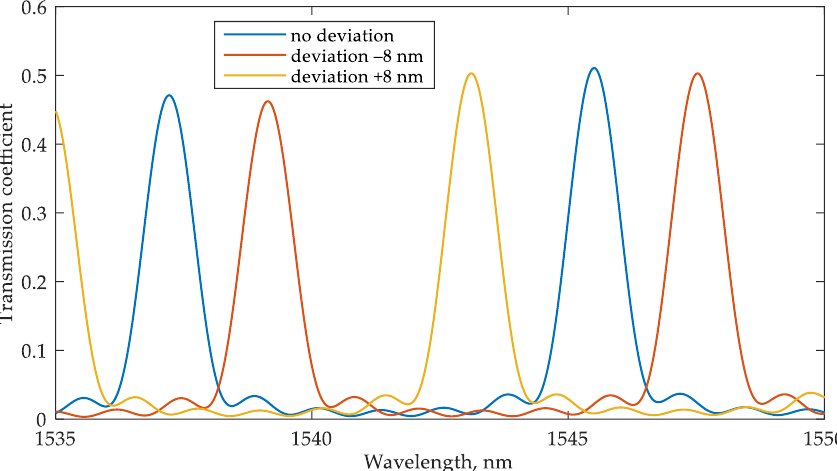
Figure 21. Interrogator ’ s transmission spectra for the fabrication deviation in the waveguide width of ±8 nm. of ± 8